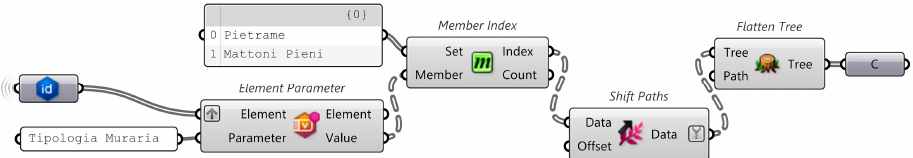
Figure 8. Portion of code reading, for selected walls, the wall typology.